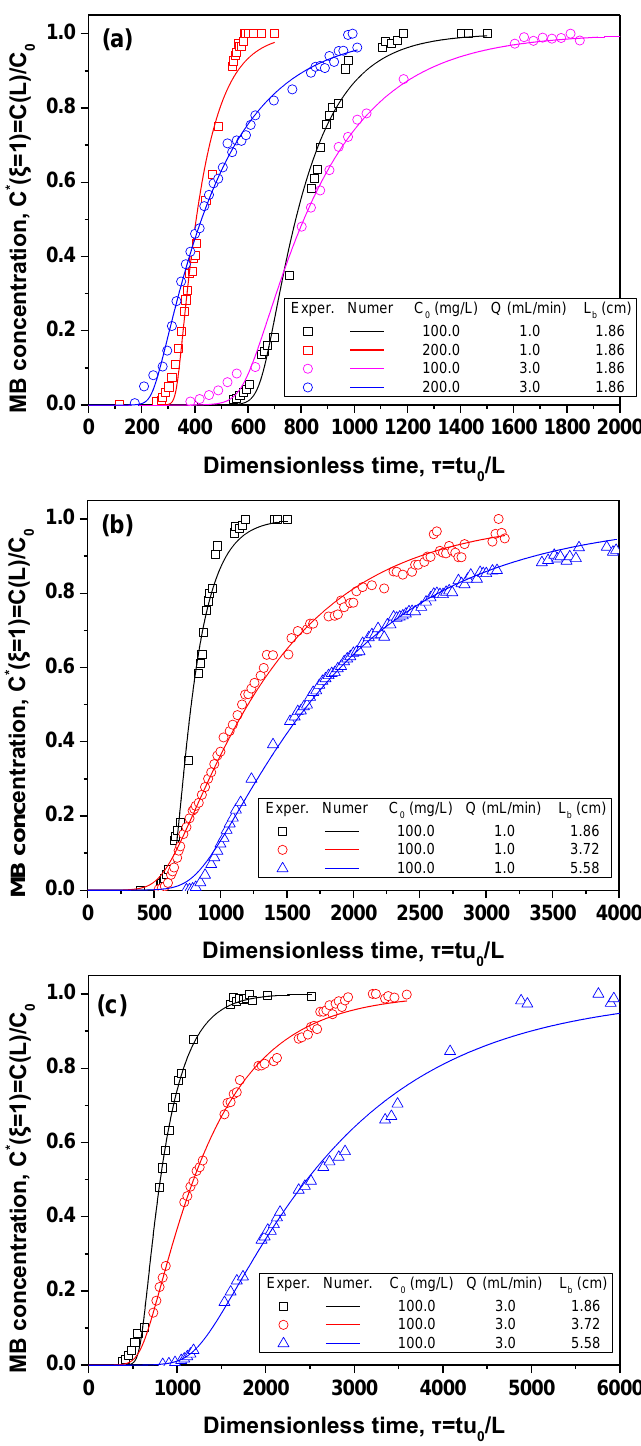
Figure 5. Experimentally measured vs. numerically predicted breakthrough curves of the MB concentration under varying flow conditions in a fixed-bed column of BP grains. ( a ) Effect of the inlet MB concentration on the breakthrough curves. ( b ) Effect of the bed length on the breakthrough curves at a low flow rate. ( c ) Effect of the bed length on the breakthrough curves at a high flow rate.